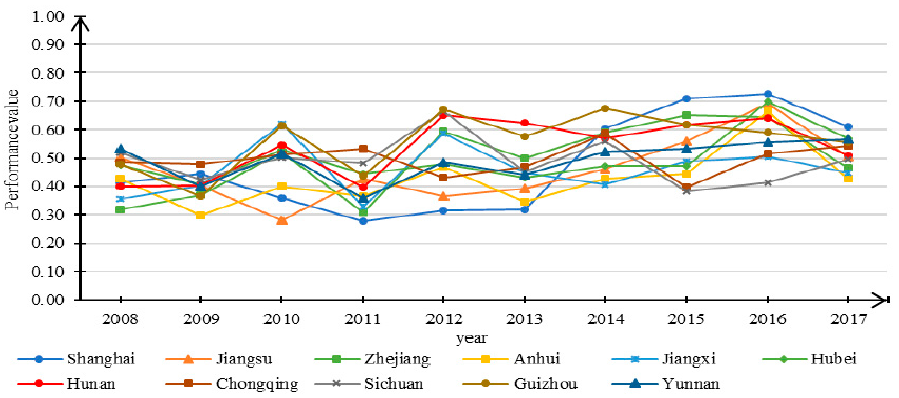
Figure 5. Trend in the performance levels of water ecosystem for 11 studied regions from 2008 to 2017.